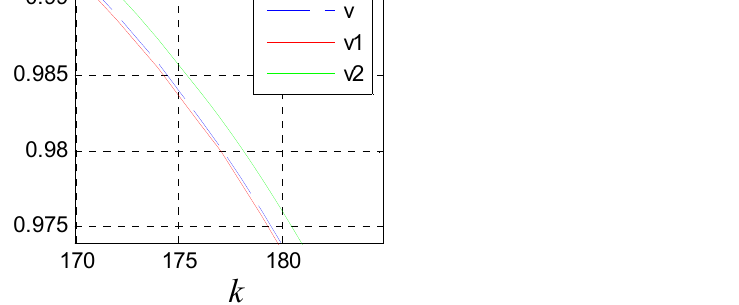
Figure 19. Compensation effect diagram for x